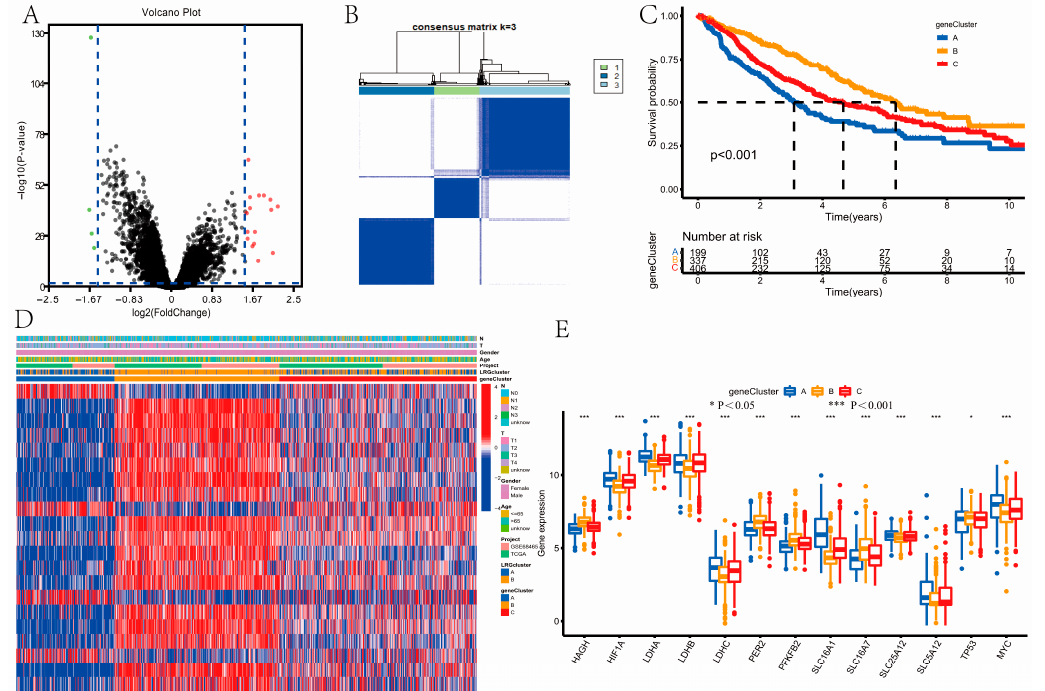
Figure 4. Identification of gene subtypes. ( A ) Differentially expressed genes (DEGs) between the two LRGclusters. ( B ) The result of consensus clustering analysis based on DEGs. ( C ) Differences in overall survival between the distinct gene subtypes. The patients in gene cluster B had the best prognosis, whereas patients in gene cluster A had the worst prognosis, using the Kaplan–Meier method and log-rank test ( p < 0.001). ( D ) The expression levels of lactate-related genes (LRGs) and clinicopathological features of samples with lung adenocarcinoma (LUAD) between the three gene clusters. ( E ) Differences in the expression of LRGs. The three gene clusters showed significant differences in LRGs expression using Wilcoxon test. * P < 0.05, ** P < 0.01, *** P < 0.001.